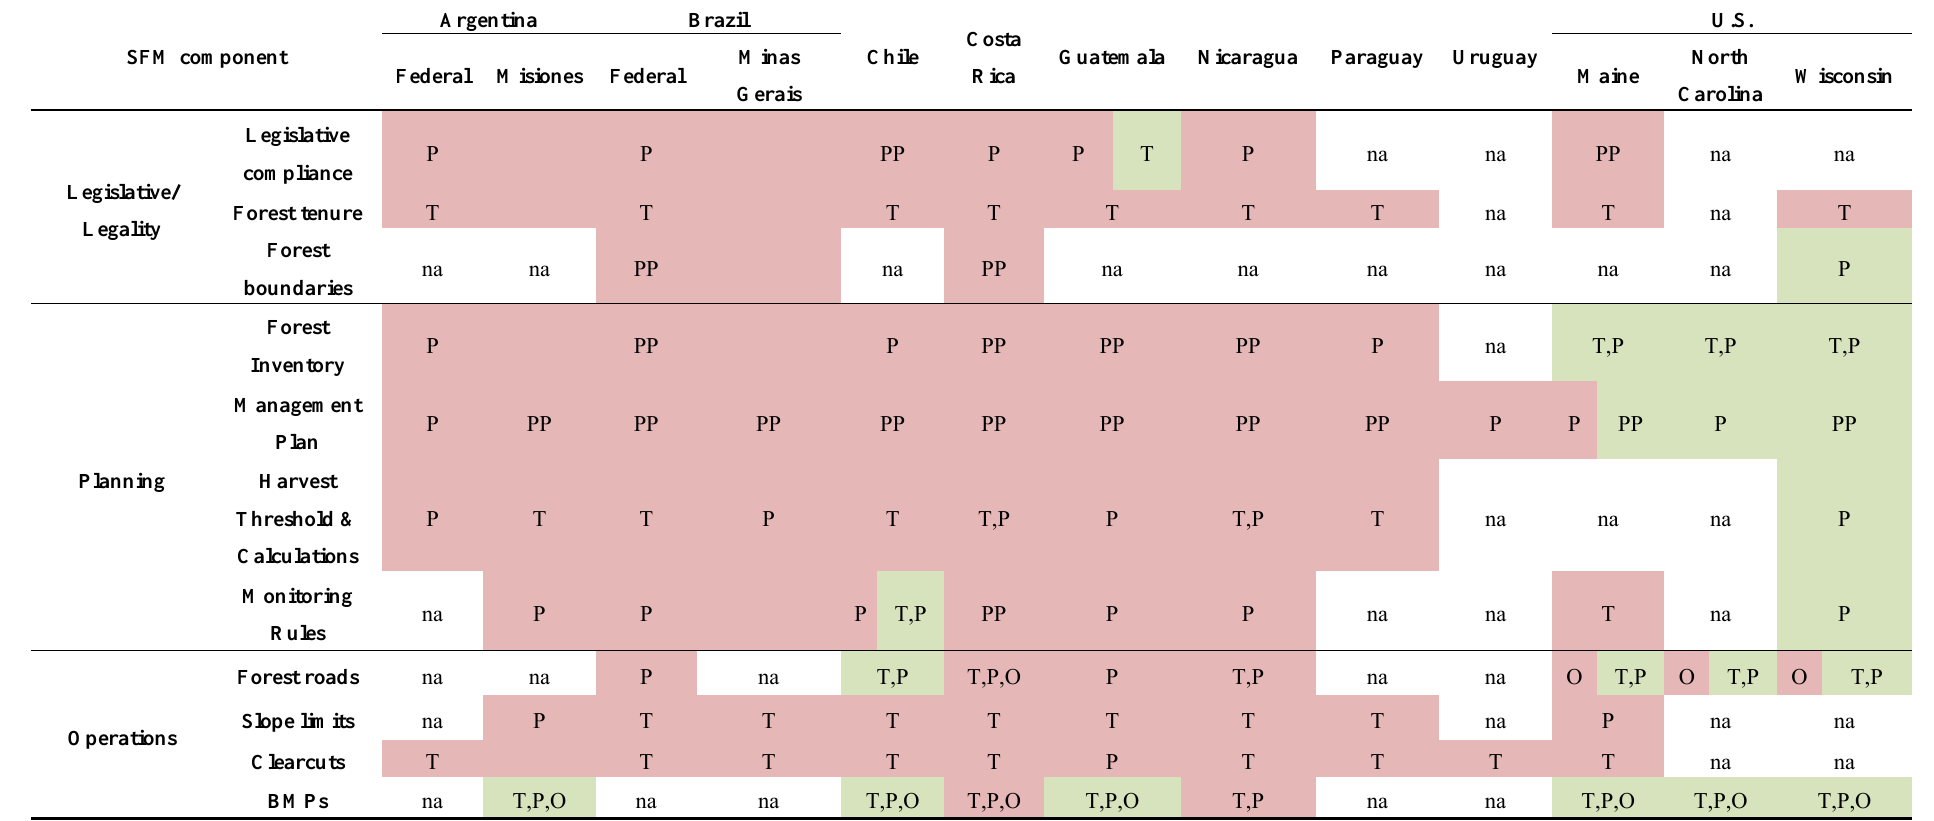
Table 3. Regulation of key components of sustainable forest management by level of obligation and approach for nine countries throughout the